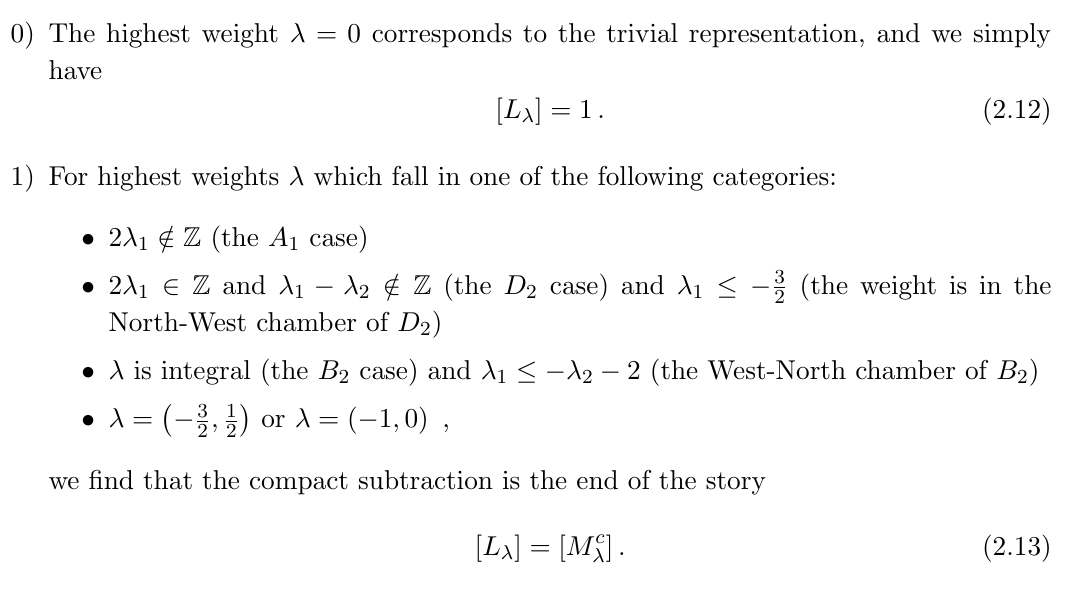
Figure 3 . Weights in blue correspond to unitary representations of the three-dimensional conformal algebra so (2 ; 3). The green circles correspond to dominant